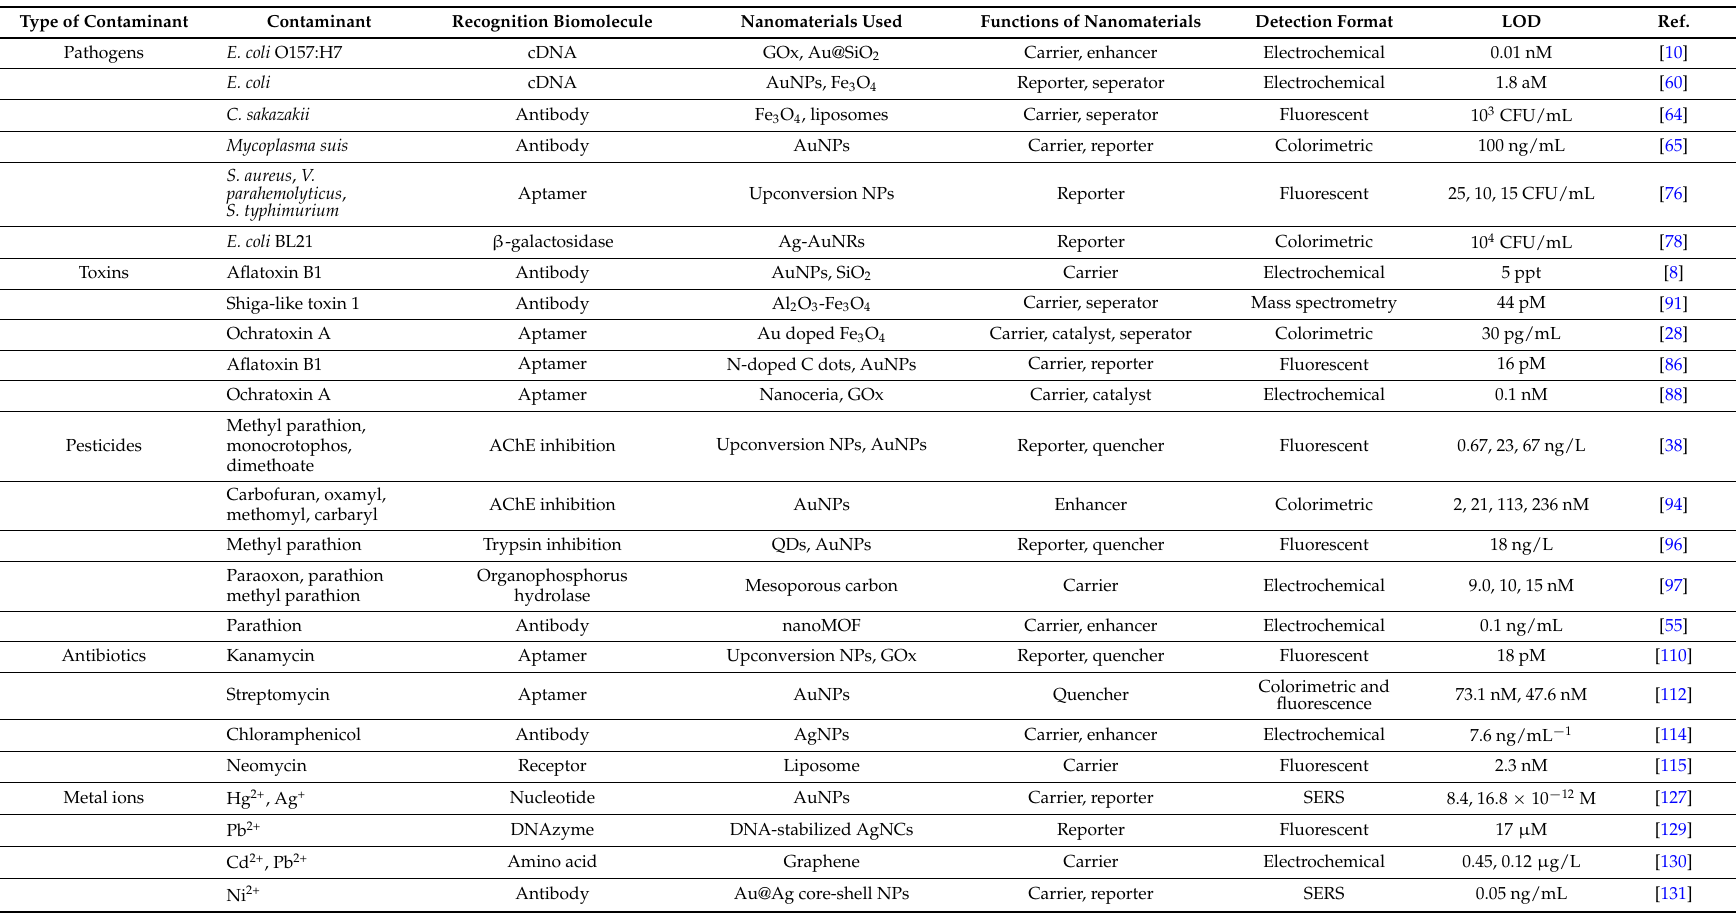
Table 2. Samples of nanobiosensing for the assay of food